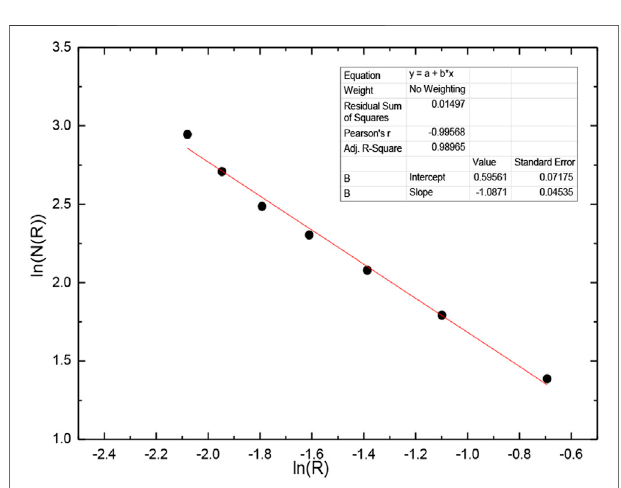
FIGURE 3 | The fractal dimension from box dimension